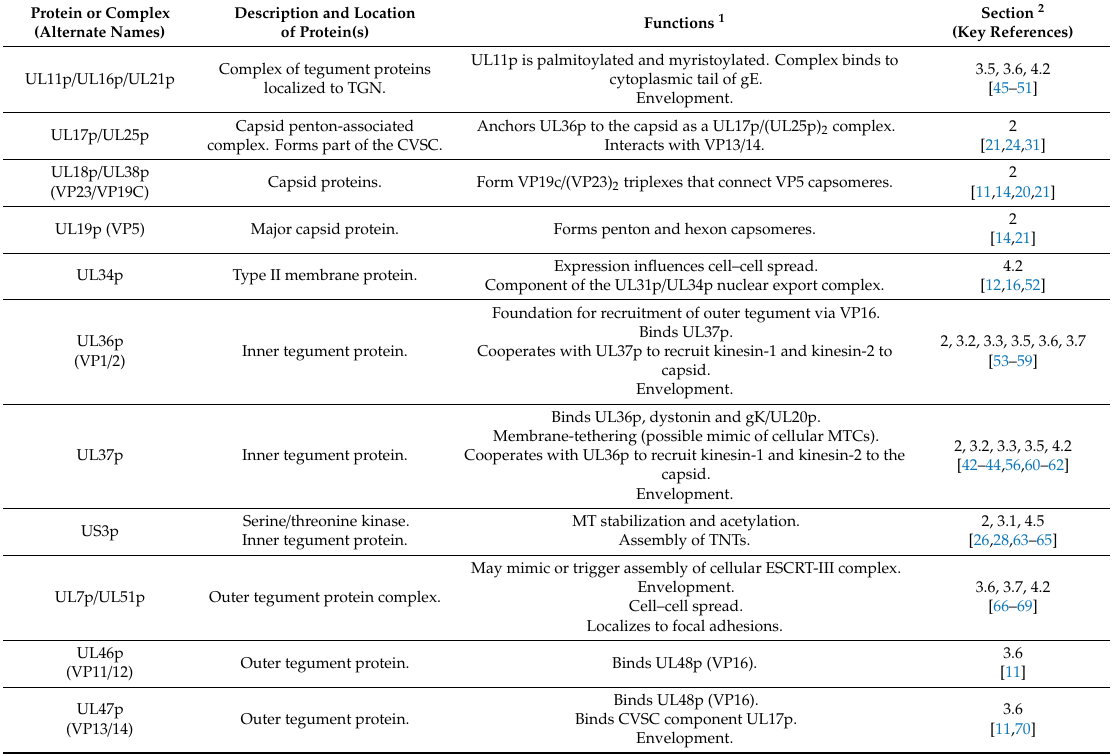
Table 1. HSV-1 structural proteins and complexes discussed in this